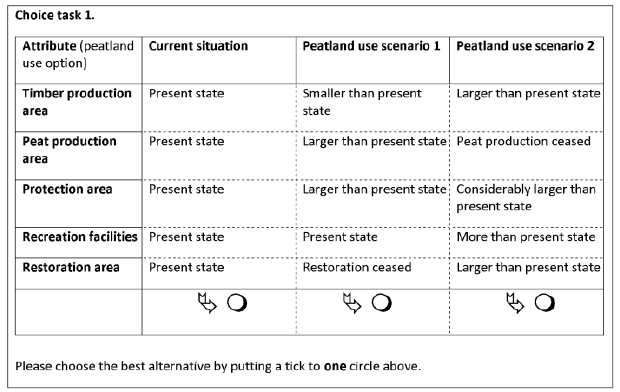
Fig. 1 . An example of a choice task including three alternative peatland use